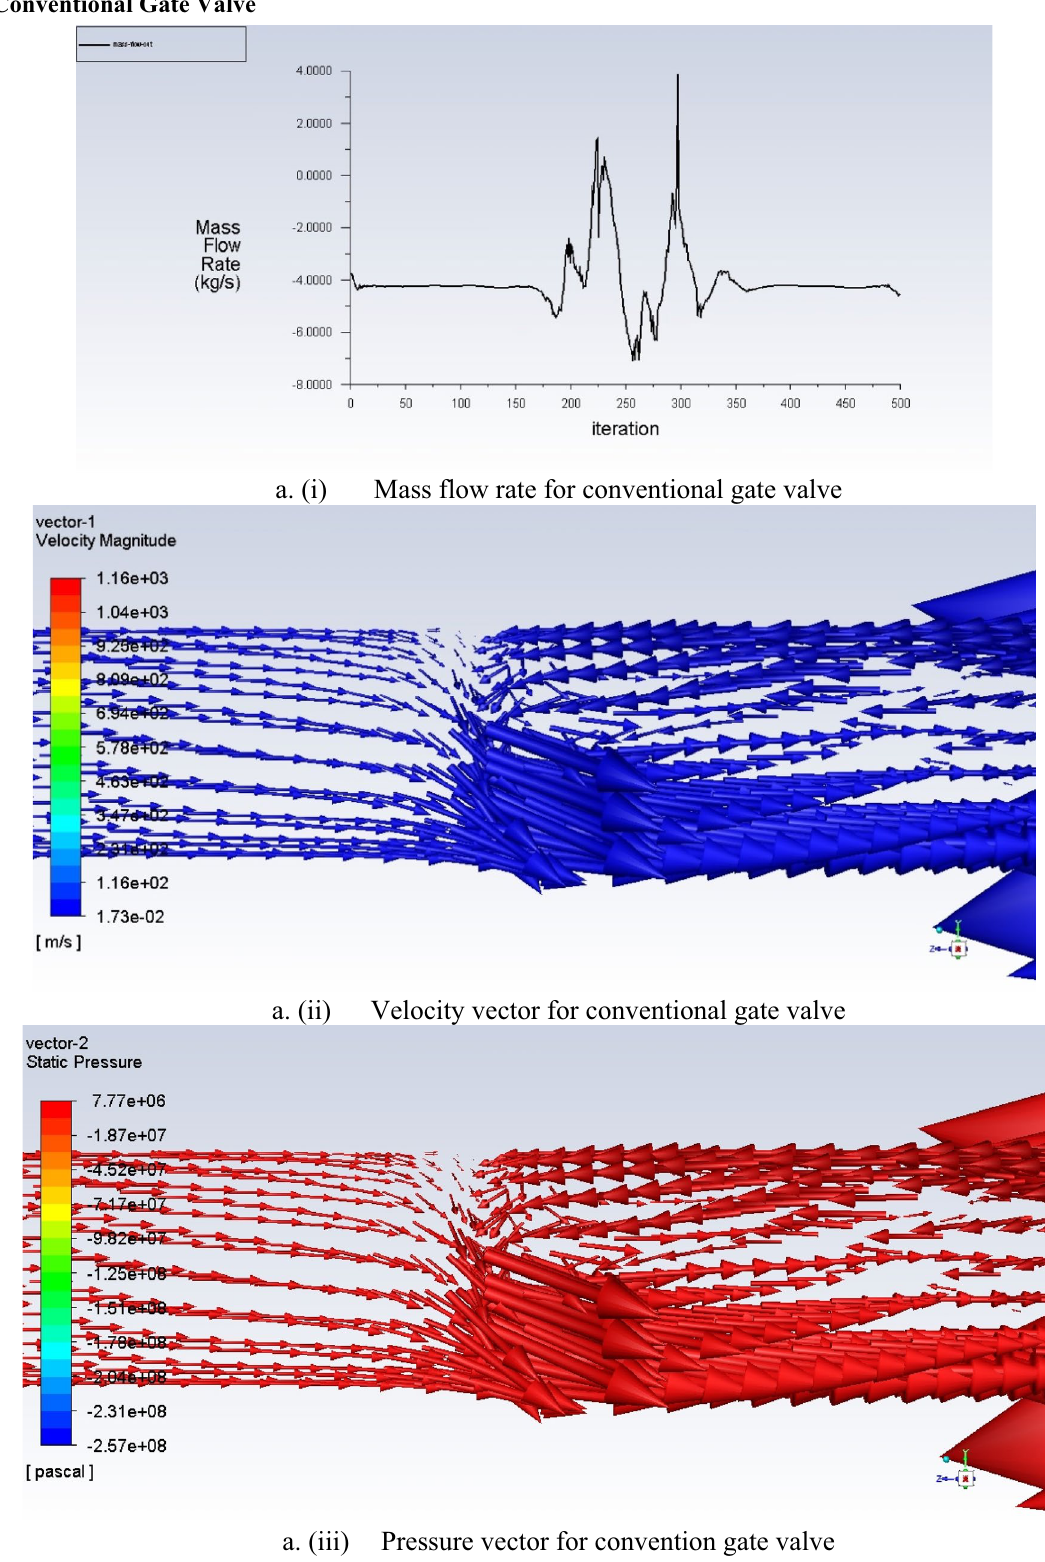
Fig. 11 Mass flow rate, velocity vector and pressure vector by CFD analysis for flow through pipe using ( a ) convention and ( b ) modified gate valve for critical 25% gate